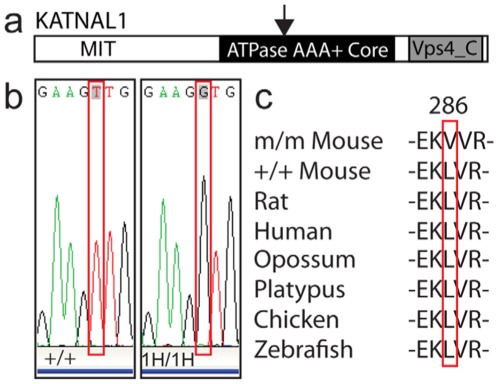
Genetic mapping identified a loss of function allele of Katnal1 as the causal genetic lesion.Genome-wide SNP linkage analysis identified a single region of distal chromosome 5 as the site of the causal mutation. Quantitative RT-PCR analysis and DNA sequencing analysis of genes within the critical region identified a single point mutational change (Thymine to Guanine) within exon seven of the gene encoding the putative microtubule severing protein Katnal1 (a, b) (The mutated allele was designated Katnal11H). The point mutation within Katnal11H generates a Leucine to Valine substitution at residue 286, within the conserved ATPase AAA-Core domain of the KATNAL1 protein (a, b). (c) Comparative genome analysis of KATNAL1 peptide sequence across diverse species demonstrated complete conservation of the Leucine residue for at least 400 million years.